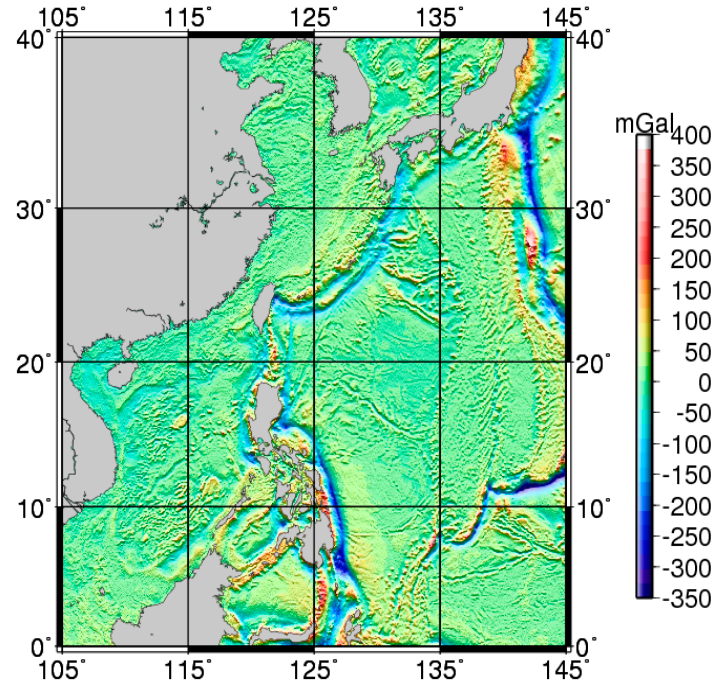
Figure 3. Schematic view of gravity anomaly reference map.